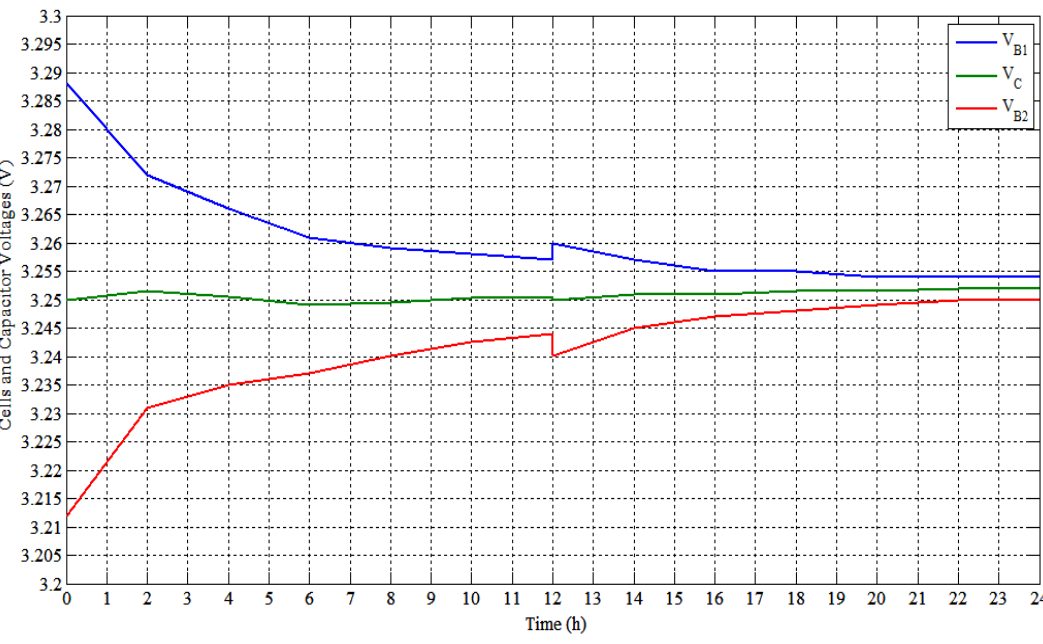
Figure 26. Experimental results of 2.3 A·h cells with SSC balancing (Test No. 1).